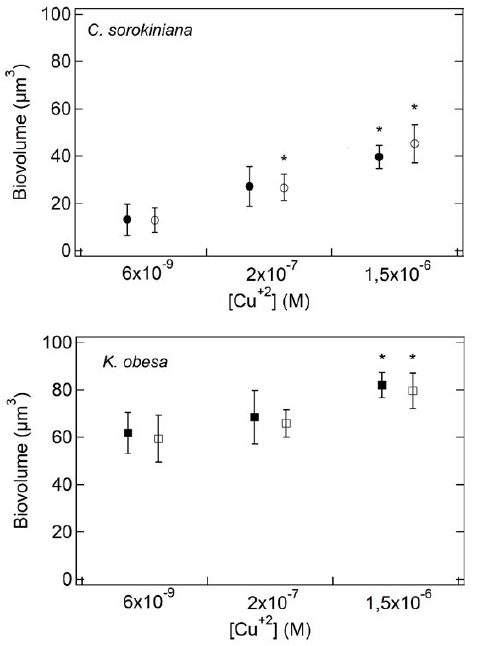
Figure 5. Biovolume (μm 3 ) of Chlorella sorokiniana (up) and Kirchneriella obesa (down) in unialgal conditions (black symbols) and co-cultivation (white symbols) measured after 72h of growth as a function of all three copper concentrations tested with mean ± standard deviation. The symbol * represents statistically significant difference (p < 0.05) regarding the control.